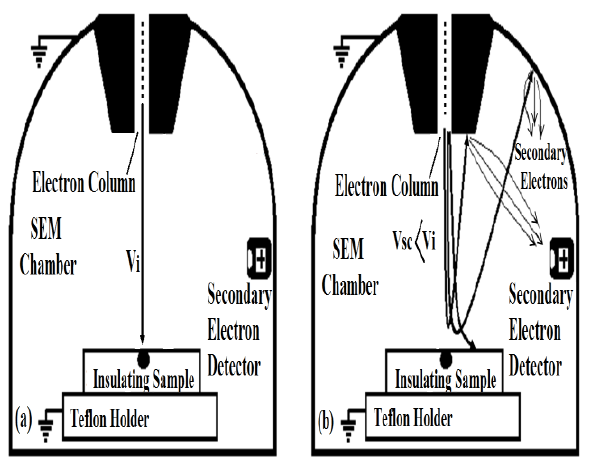
Fig.1: Schematic illustration of the charging process (a) and the SEM mirror image formation